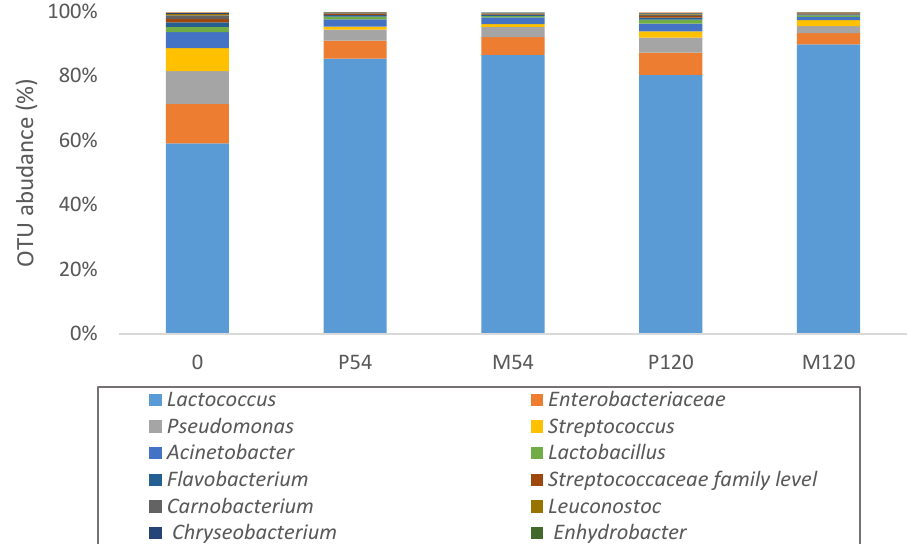
Figure 2. Abundance of the main genera found in the feta cheese PDO samples during ripening (0,54, 120 days) in plastic (P) and stainless steel (M) container. The genera with abundance > 0.1% in at least one of samples is shown; the rest of them are summarized in Table S1.